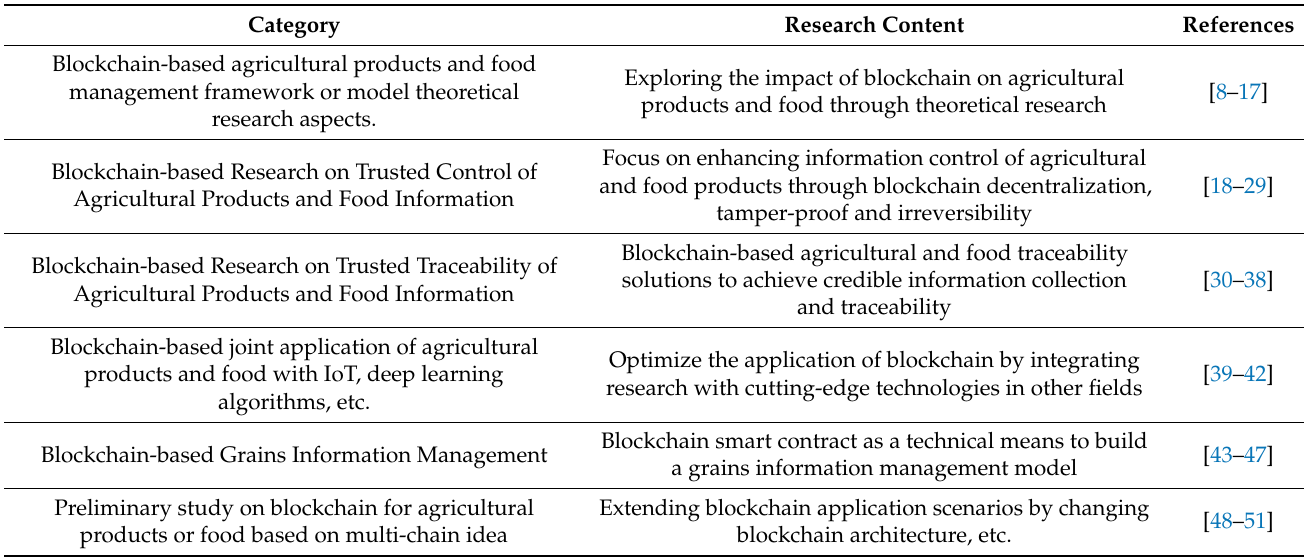
Table 1. Research review